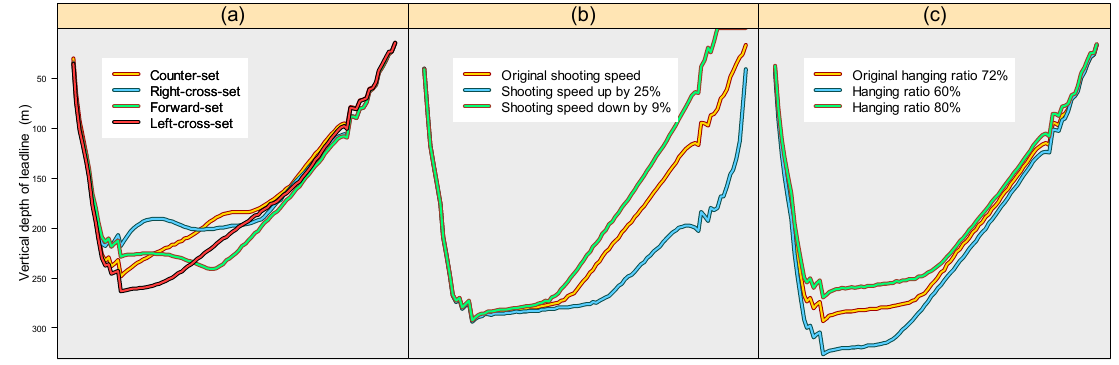
Figure 8. Vertical depth of the entire lead line at the end of shooting. ( a ) Under four types of settings at 0.4 Kn uniform current: counter-set, right-cross-set, forward-set, and left-cross-set. ( b ) Under different shooting speeds: normal, 1.25 times the normal, and 0.91 times the normal. ( c ) Three types of net with different average hanging ratio: 72% (normal), 60%, and 80%.